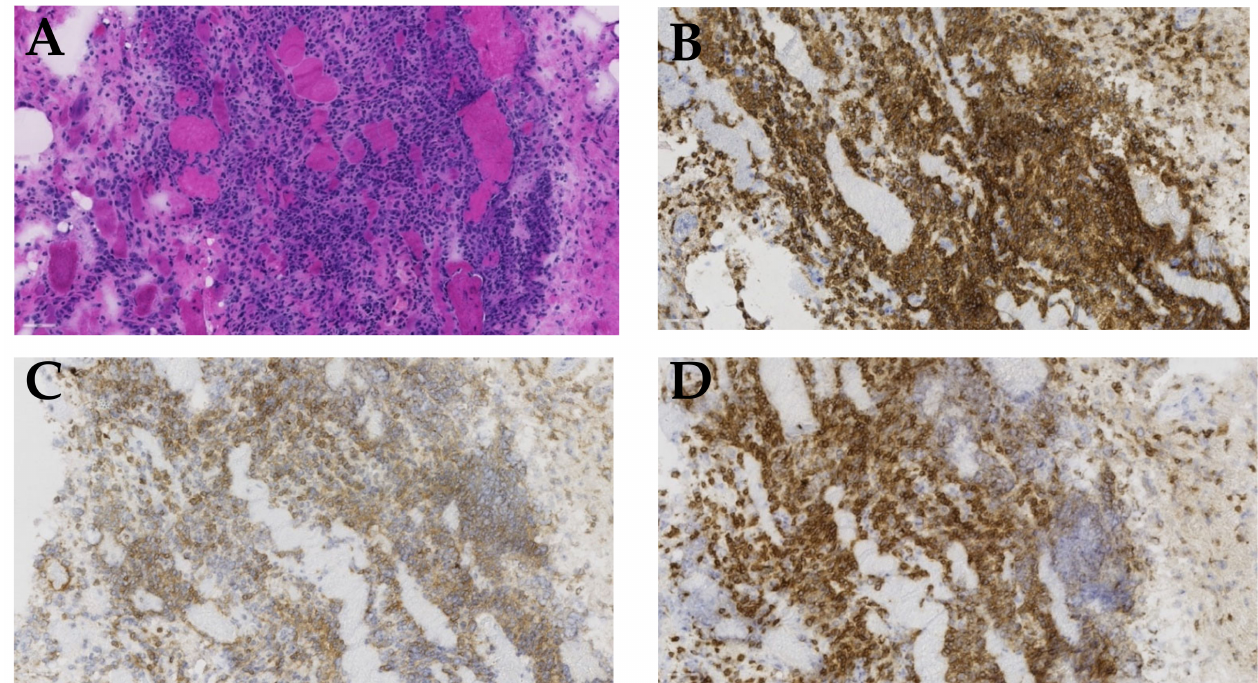
Figure 1. Histopathological features of muscle biopsy. This figure demonstrates the results of a biopsy from the left quadriceps femoris muscle, taken from our patients. ( A ) Hematoxylin–eosin staining reveals that large amounts of the muscle tissue have been replaced by inflammatory cells. ( B ) Immunohistochemical staining for CD45 shows massive amounts of leukocytes present in the tissue sample. ( C ) Immunohistochemical staining for CD4 shows a massive infiltration of CD4+ lymphocytes. ( D ) Immunohistochemical staining for CD8 demonstrates an extensive infiltration of CD8+ lymphocytes. All the histopathological images are shown in 40 ×